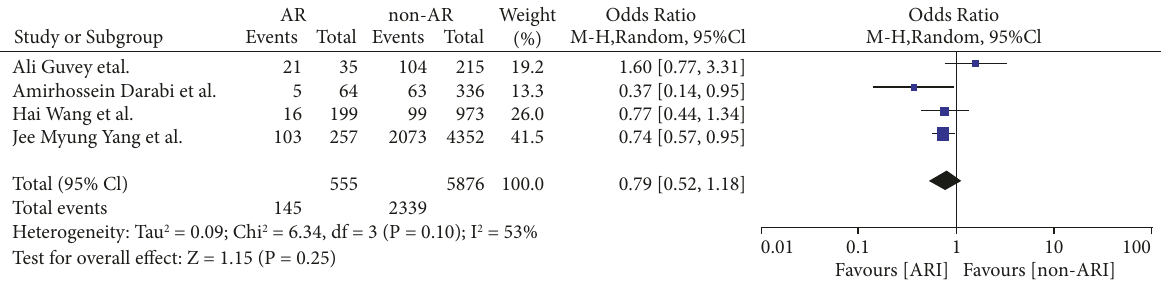
Figure 4: Incidence of severe COVID-19 with and without AR of stay forest plot.